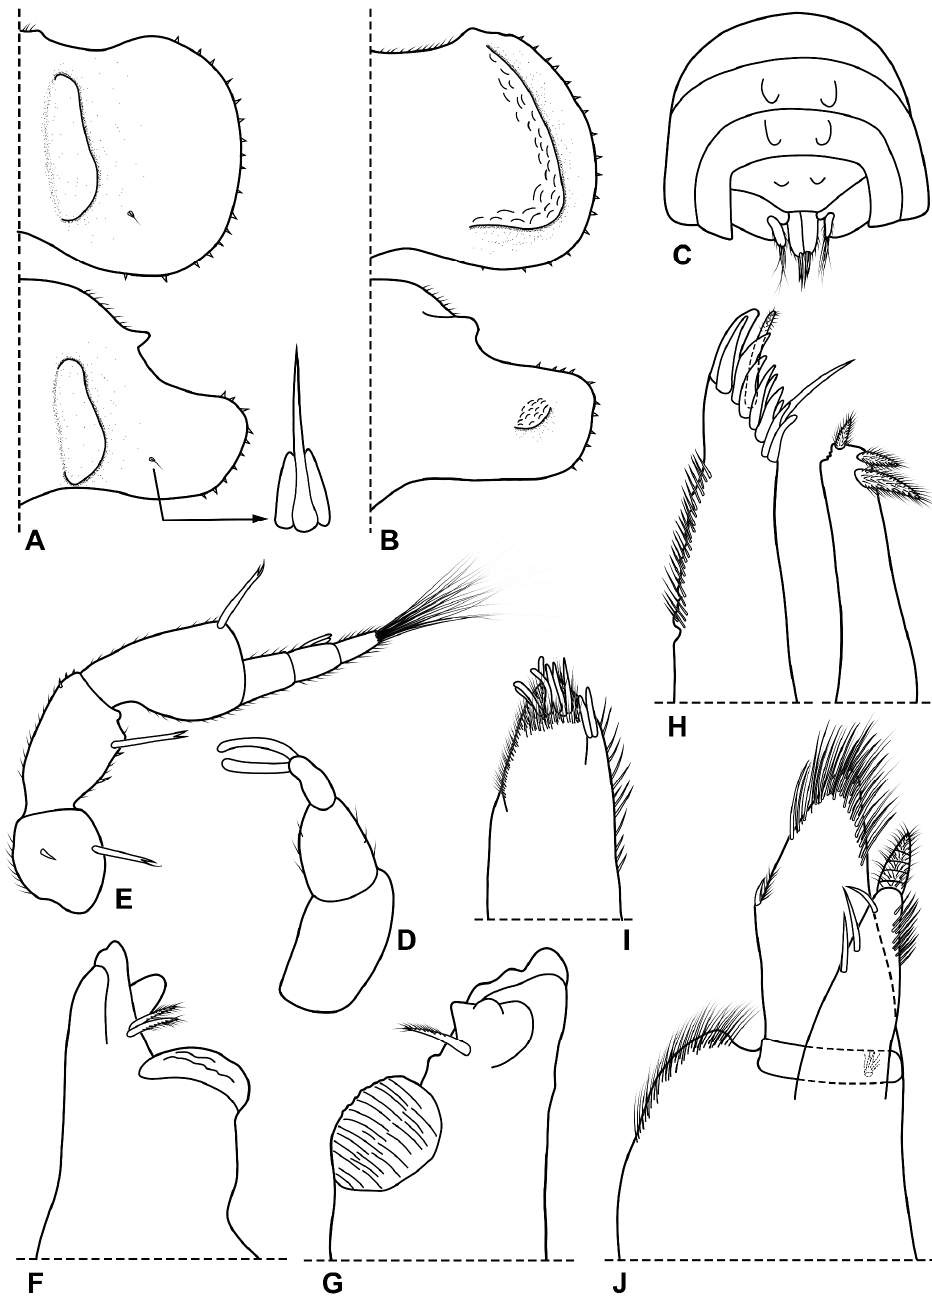
Figure 2. Buddelundiella zoiai sp. n., paratype ♀ from Murialdo. ( A ) Epimera of pereonites 1 and 2, dorsal view. ( B ) Epimera of pereonites 1 and 2, ventral view. ( C ) Pleon, telson and uropods, dorsal view. ( D ) Antennula. ( E ) Antenna. ( F ) Left mandible. ( G ) Right mandible. ( H ) Maxillula. ( I ) Maxilla. ( J ) Maxilliped.